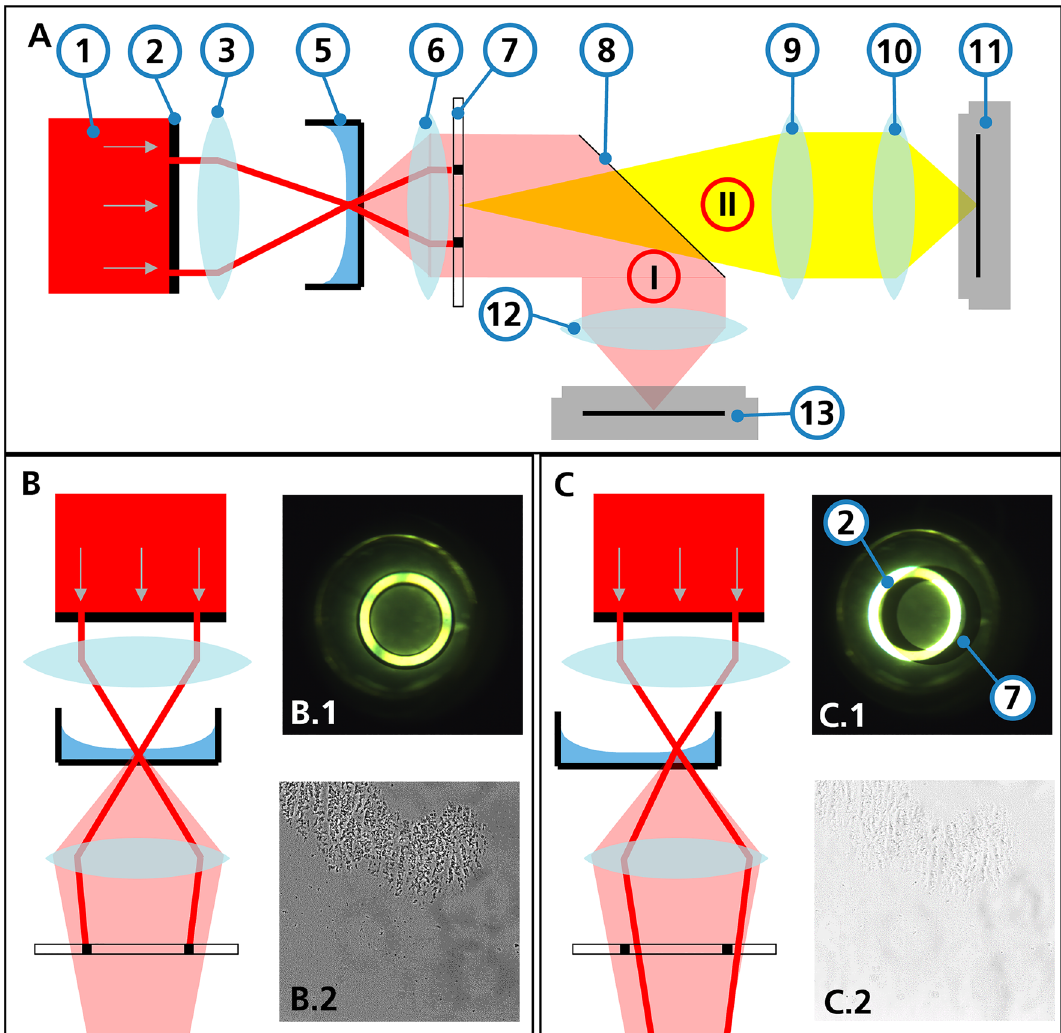
Figure 1. Schematic representation of the illumination path in a phase contrast microscope with different well positions. ( A ) Simplified light path through the microscope (non-active elements such as deflecting mirrors and glass plates have been omitted). (1) Light source (2) Condenser annulus (3) Condenser lens (5) MTP (6) Objective lens (7) Phase ring (8) Movable mirror (9) Bertrand lens (10) Ocular lens (11) Secondary camera (12) Tube lens (13) Main camera. By moving the mirror (8), it can be switched between the main light path (I) and the secondary light path (II) to observe the phase ring and condenser annulus overlap. ( B ) Light passes through the center of the well. ( B.1 ) Superposition image of phase ring and condenser annulus. They completely overlap. ( B.2 ) Resulting phase contrast image of cell culture. ( C ) Due to the curvature of the surface towards the edge of the well, the light beam is refracted away from the center. ( C.1 ) In the superposition image, the deviation between the condenser annulus (2) and the phase ring (7) is visible. ( C.2 ) The resulting cell image is thus taken under brightfield conditions. Images ( A.2 ) and ( B.2 ) were taken with a 10x Objective (Nikon CFI Plan Fluor DL 10XF) in a 6-well